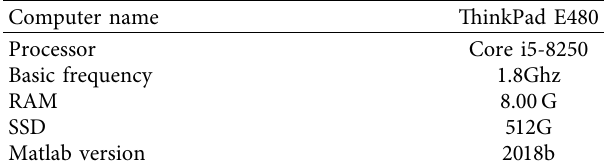
Table 2: Parameters of the